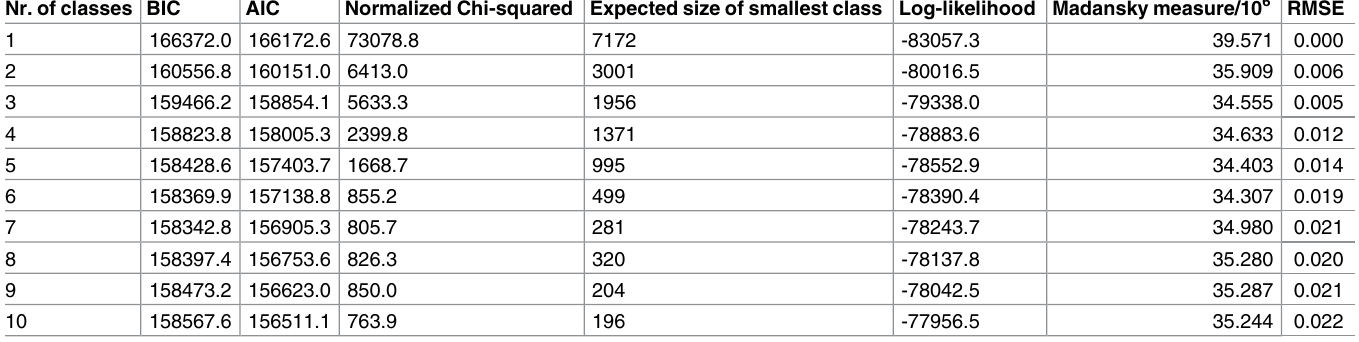
Table 2. Fit statistics of latent class clustering of cardiovascular risk factors and diseases (primary analysis with AF as class-determining variable). Nr. of classes